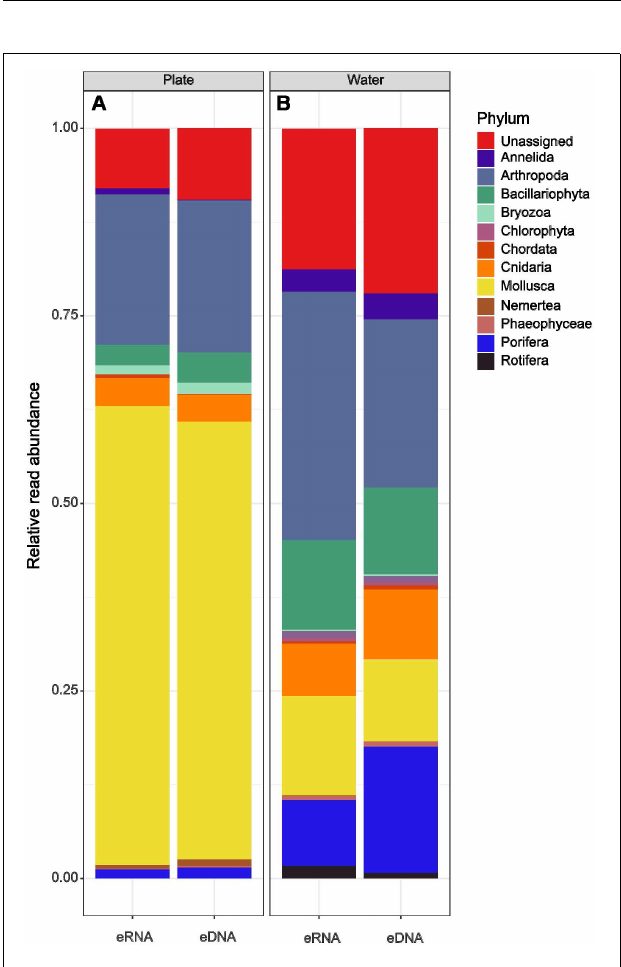
FIGURE 3 | Venn diagrams displaying shared and unique Amplicon Sequence Variants (ASVs) between environmental RNA and unique ASVs among environmental DNA datasets for: (A) plate samples, and (B) water samples.